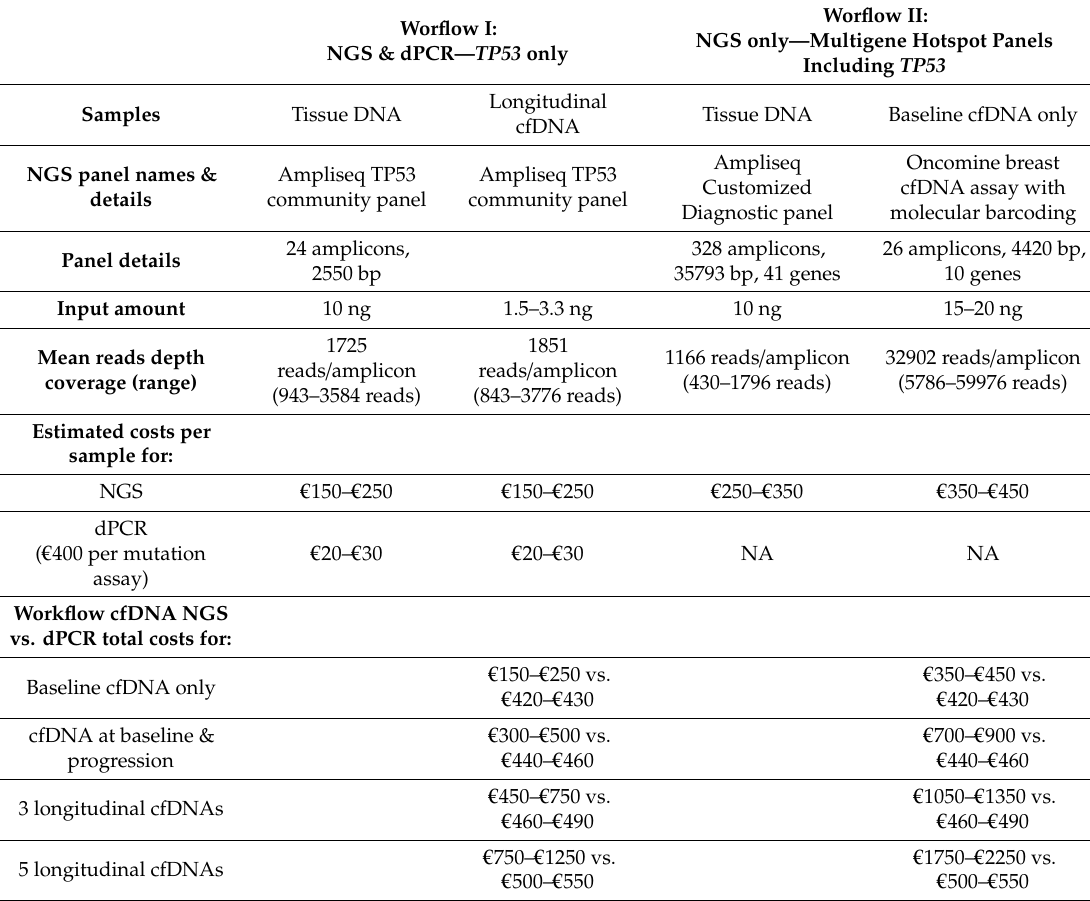
Table 2. Cell-free DNA (cfDNA) workflow